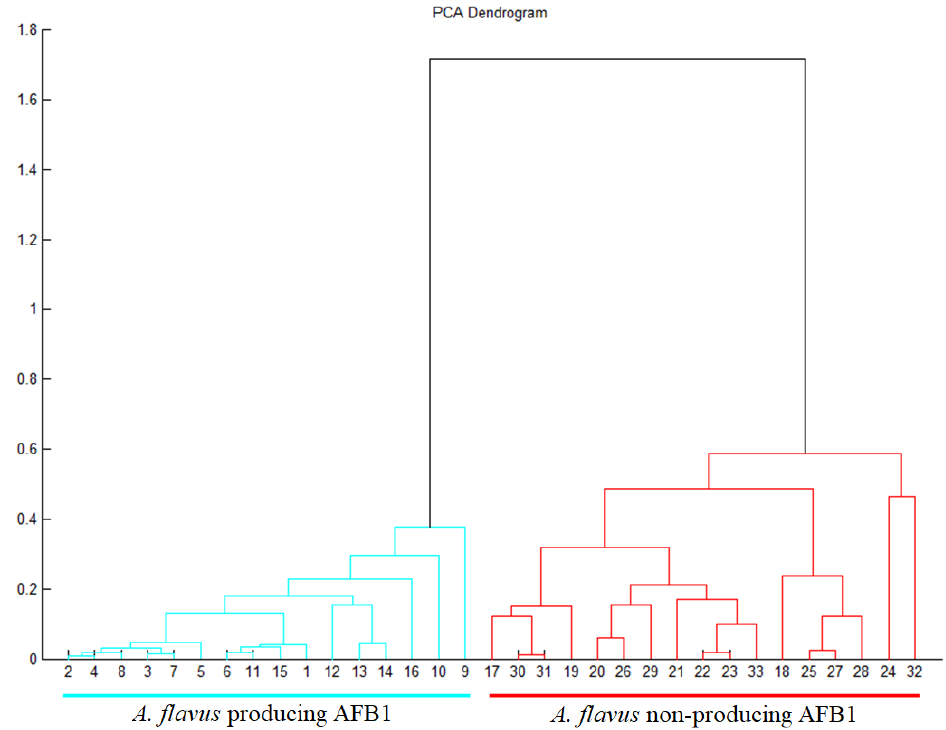
Figure 6. PCA (Principal Component Analysis) dendrogram presented relatedness between Aspergillus flavus producing AFB 1 and non-producing AFB 1 strains. Statistical evaluation divided producing and non-producing strains onto two clusters marked in different colors.